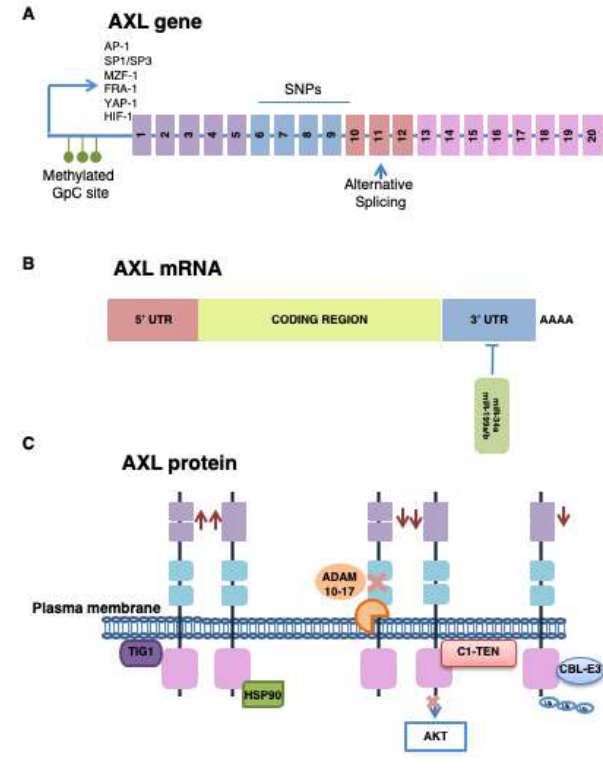
Figure 2. AXL expression: control mechanisms. ( A ) AXL expression is epigenetically regulated through methylation of the CpG islands present in its promoter. In contexts with high AXL levels, the promoter methylation is essentially absent. Moreover, the AXL gene promoter presents binding sites for more transcription factors. The splicing alternative, in exon 10, promotes the formation of two AXL functional variants; in addition, three single polymorphisms (SNPs), between exons 6 and 10, are identified. ( B ) miR-34a and miR-99a/b negatively regulate the receptor expression through their interaction with 3′UTR region of AXL. ( C ) Many proteins can negatively or positively regulate AXL’s expression or activity. A disintegrin and metalloproteinase (ADAM) domain containing protein 10 and 17 and casitas B-lineage lymphoma (CBL) E3 ligases are responsible for AXL inactivation and ubiquitination, respectively. C1 domain-containing phosphatase and tensin homolog (C1-TEN), inhibiting AXL catalytic domain, blocks its ability to active AKT. Heat-shock protein 90 (HSP90) and Tazarotene-induced gene 1 (TIG1), instead, stabilize AXL in plasma membrane.